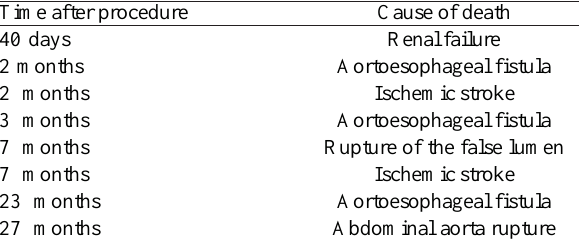
Table 6. Time from procedure to death and cause of death Time after